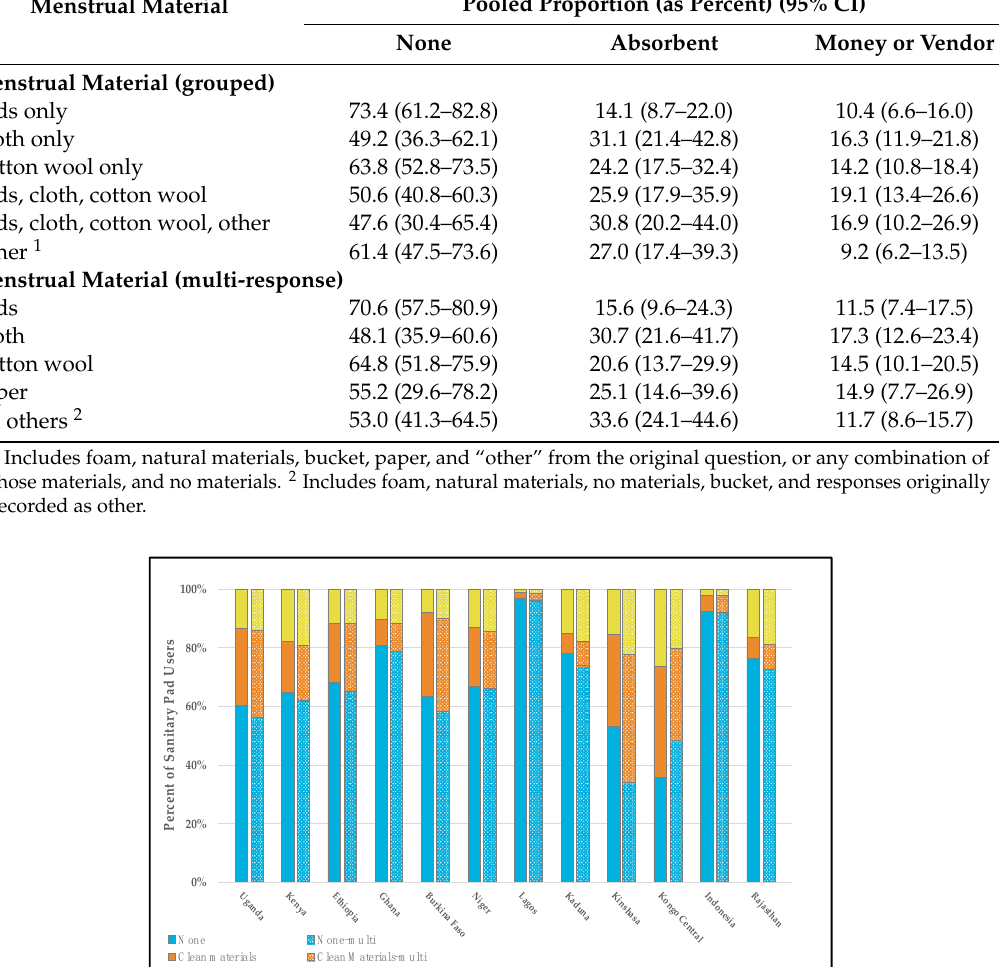
Menstrual Material